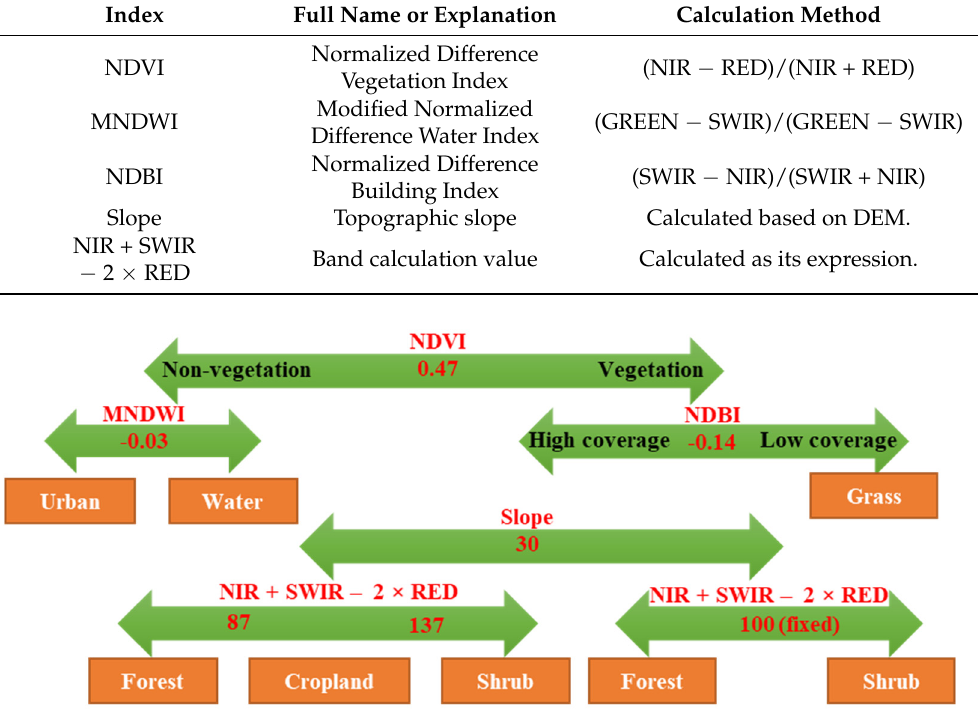
Table 1. Indices for decision tree classification.